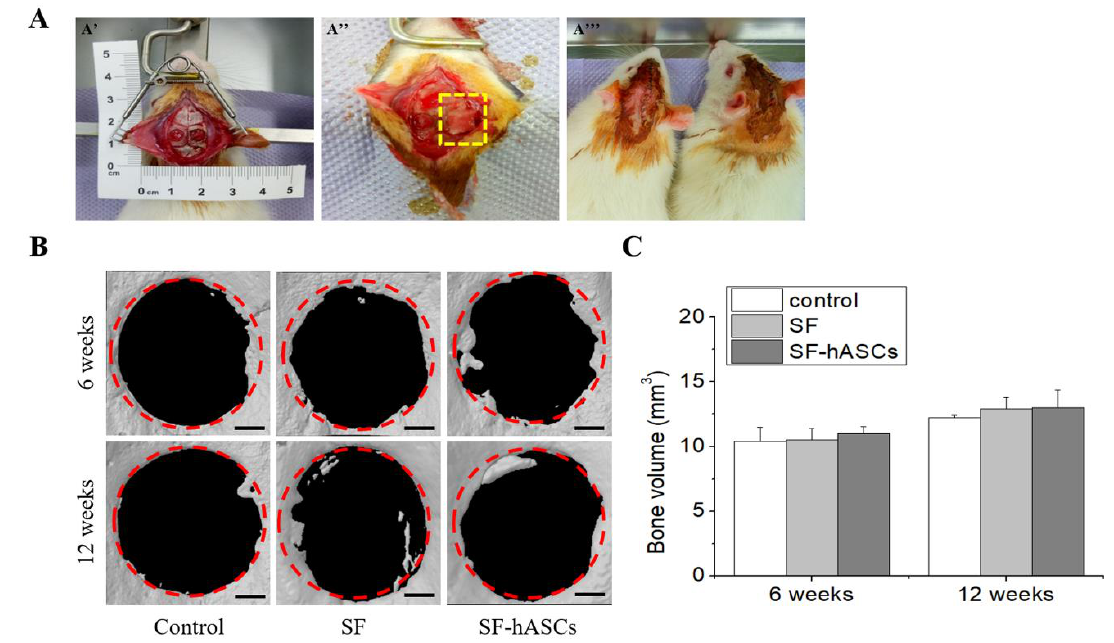
Figure 4. The rat calvarial defect model and micro-CT analysis at six and twelve weeks postimplantation. ( A ) Defects of 5 mm in diameter were created using a biopsy punch (A’); in one of these defects, the SF/SF-hASCs scaffold was inserted (yellow dash; A’’); postsurgery (A’’’); ( B ) micro-CT images of rat calvarial defects (scale bar = 1 mm); ( C ) bone volume results obtained from the quantitative analysis of micro-CT scans (n = 5).